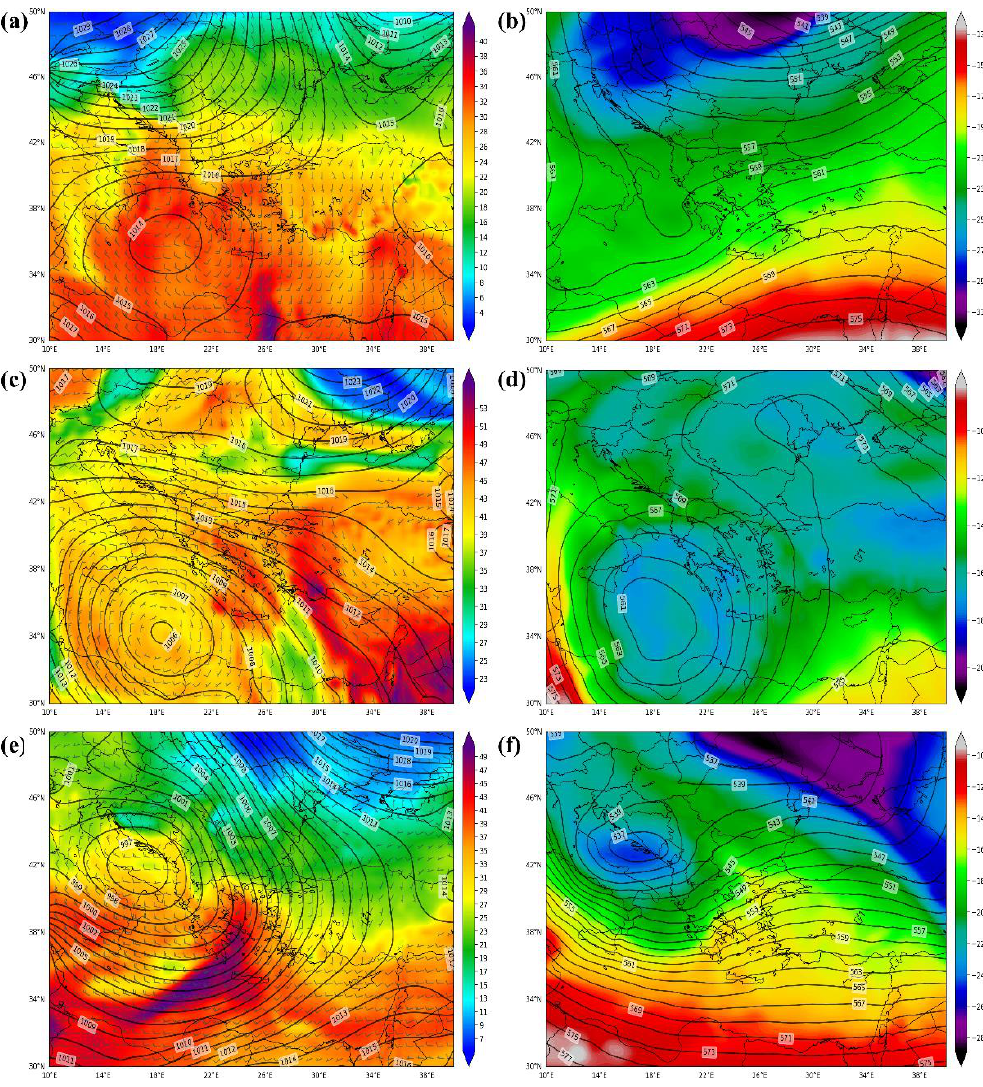
Figure 2. Sea-level pressure (contours; hPa) and 850 hPa equivalent potential temperature (shading; °C) and wind barbs ( a , c , e ), and 500 hPa air temperature (shading; °C) geopotential height (contours; dm; b , d , f ) from the 0.25° × 0.25° ERA5 reanalysis data on 17 November 2008, 1500 UTC ( a , b ), 25 October 2009, 0900 UTC ( c , d ), and 03 November 2009, 1500 UTC ( e , f ).